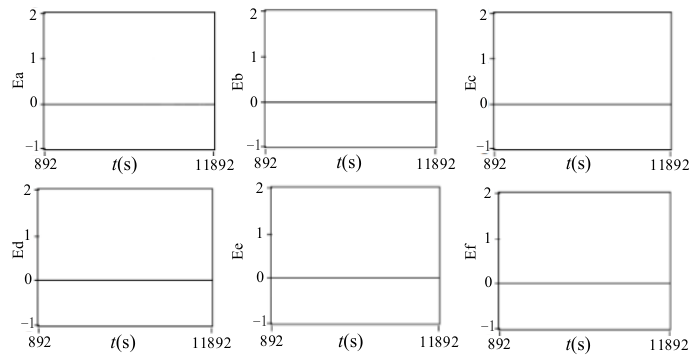
Figure 27. Fault index waveform under stable operation at 500r / min.